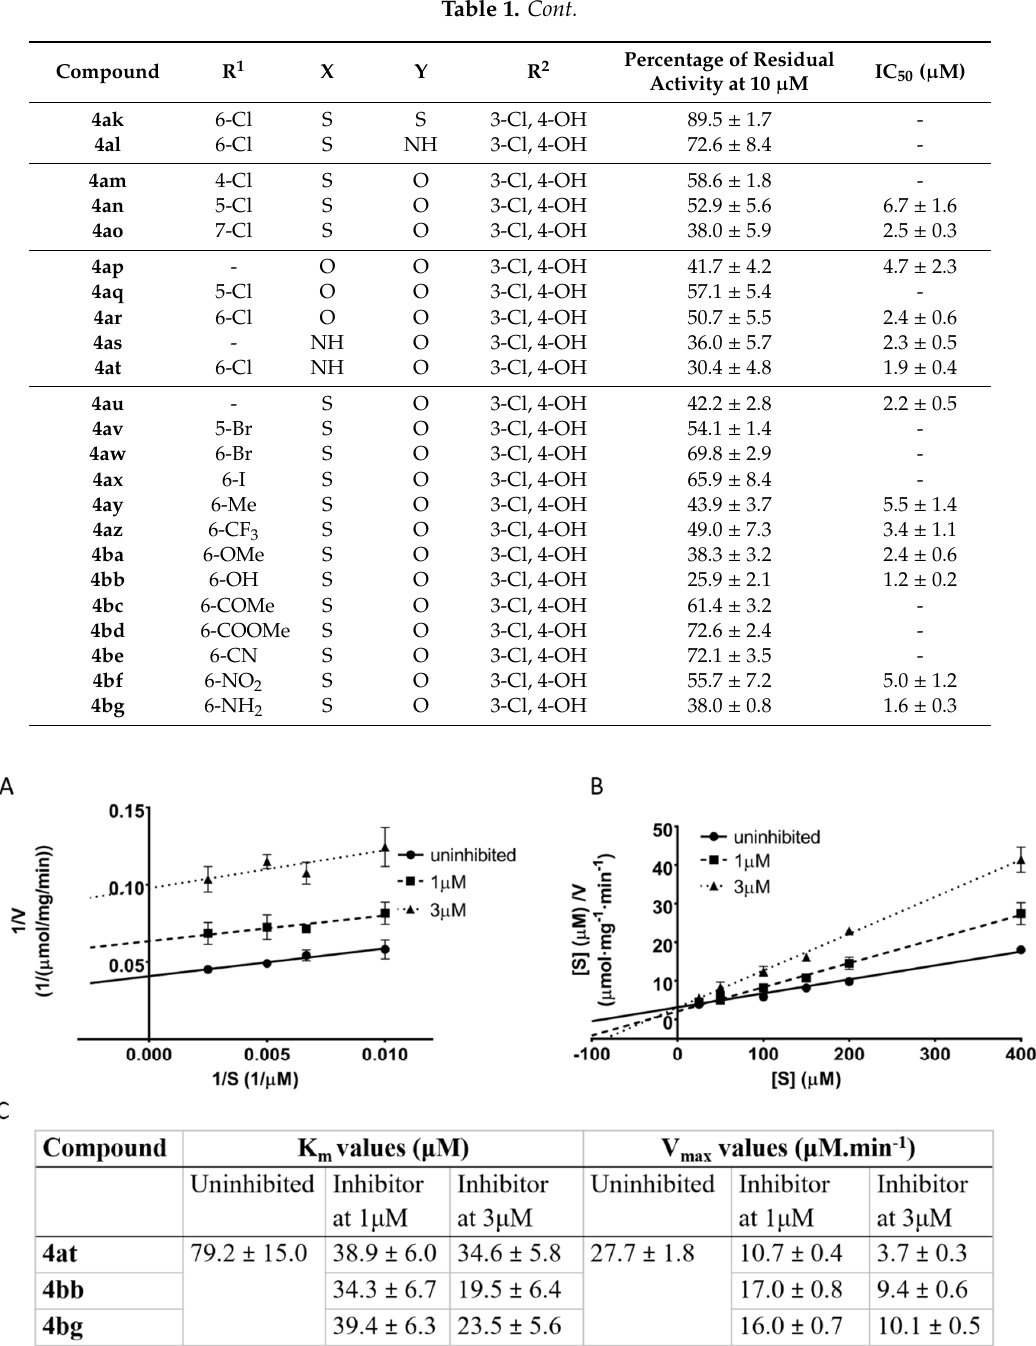
Figure 4. Determination of the mechanism of action for compounds 4at , 4bb , and 4bg . For all compounds, the uninhibited enzymatic reaction was compared with enzymatic reaction at two concentrations of each particular inhibitor. ( A ) Lineweaver-Burk plot of compound 4at (plots for 4bb , and 4bg in Supplementary Materials); ( B ) Hanes-Wolf plot of compound 4at (plots for 4bb , and 4bg in supplementary); ( C ) comparison of kinetic parameters K m and V max between uninhibited and inhibited reactions.